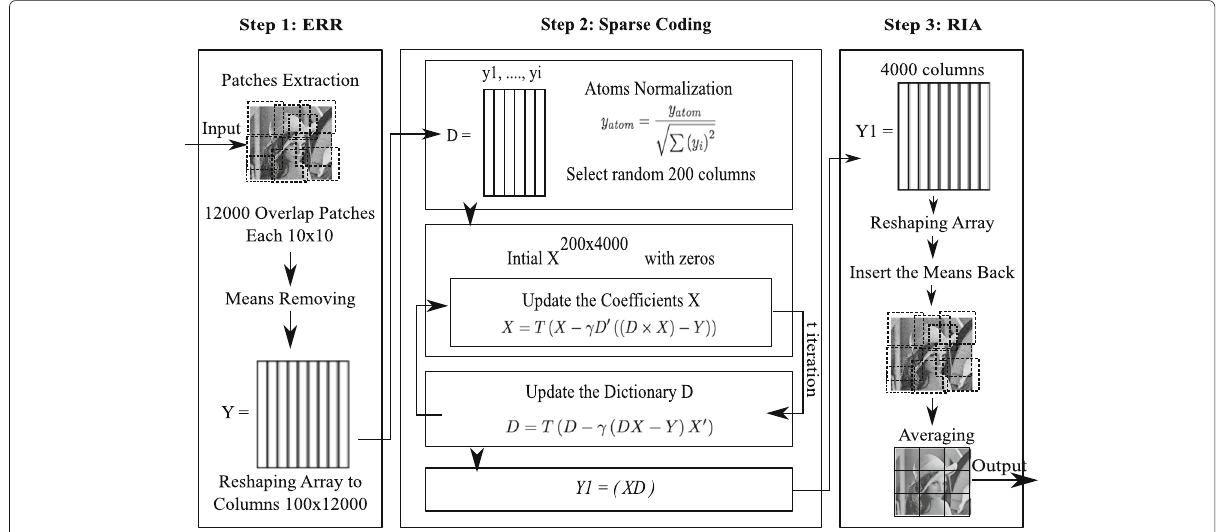
Fig. 4 K-SVD filter: dictionary learning scheme of the K-SVD filter